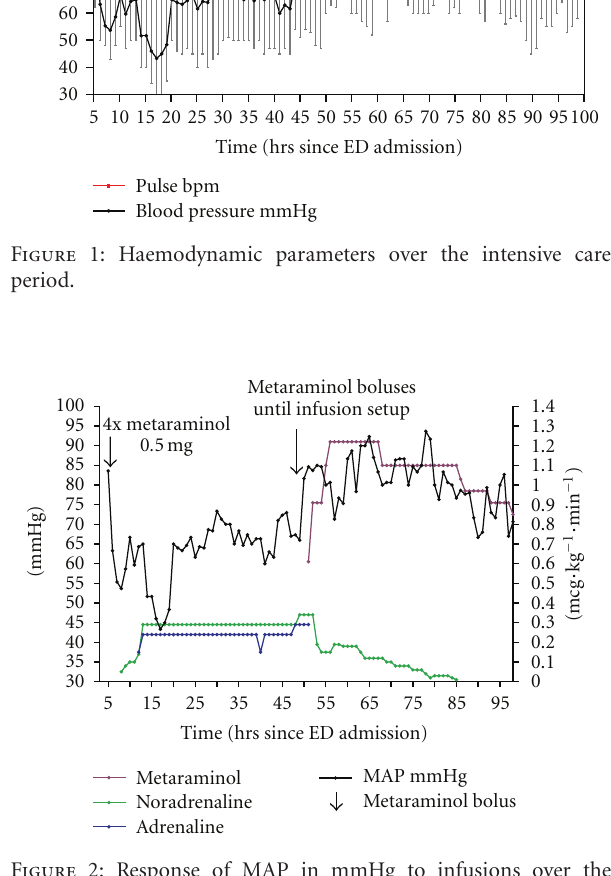
Figure 2: Response of MAP in mmHg to infusions over the intensive care period. Note: left y -axis MAP in mmHg, right y - axis infusions of ionotropes in mcg · kg − 1 · min − 1 . Arrows show metaraminol